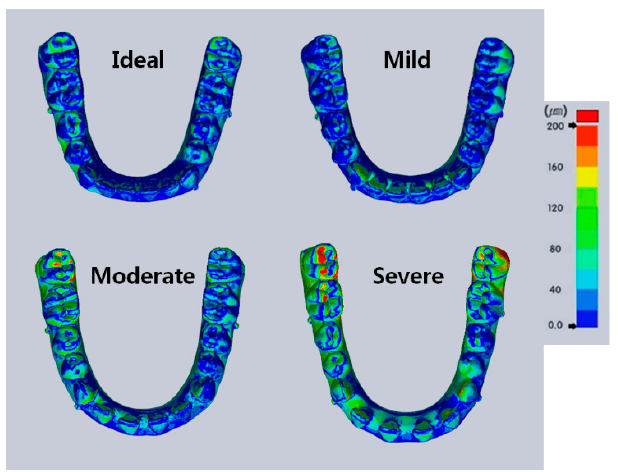
Figure 8. Representation of deviations when using Trios ® Color map was set from 0 μ m to +200 μ m. Ideal: ideal dental arch; Mild: 1 mm spacing; Moderate: 3 mm spacing; and Severe: 5 mm spacing. Red represents areas of large deviations; Blue represents areas of small deviations. The deviation of Ideal is the smallest; that of Mild is larger than Ideal; that of Moderate is larger than Mild; and that of Severe is the largest, especially in the posterior area.